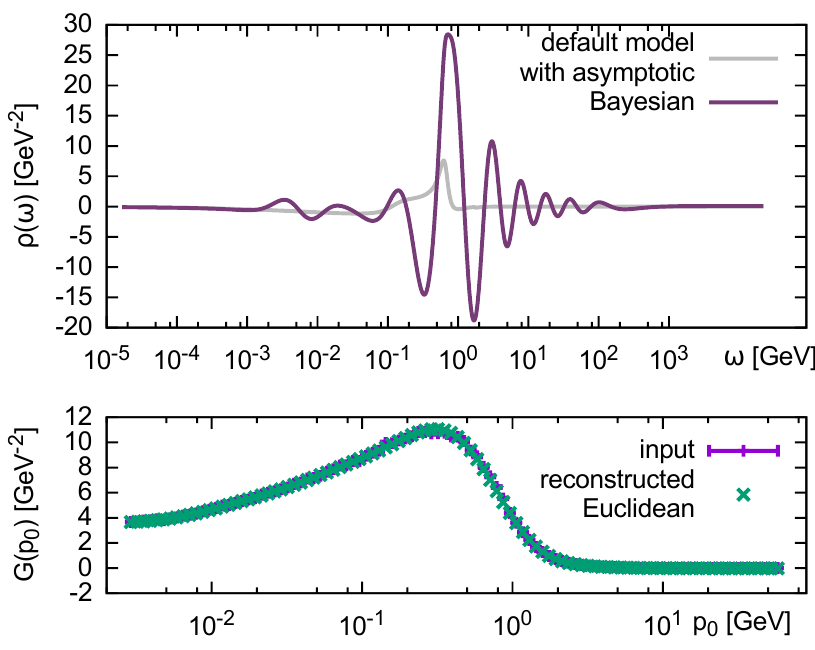
Figure 9: (top) Representative example of a Bayesian reconstruction of the gluon spectral function based on FRG Euclidean data in the scaling scenario. One hundred data points with a relative error of 10 − 2 were supplied, as well as a default model (gray solid), which produces the correct asymptotics of the correlator. We find that while the asymptotics are correctly recovered in the final result (solid violet) even- tually, the agreement emerges far later than in our new method. In addition we find that the non-perturbative region at around ω ∼ 1GeV is contaminated by strong ringing artifacts (bottom) Comparison between the reconstructed Euclidean correla- tor (green) and the input data